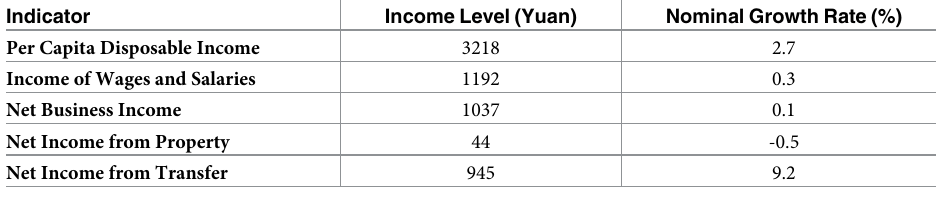
Table 1. Income of rural residents in poor areas in the first quarter of